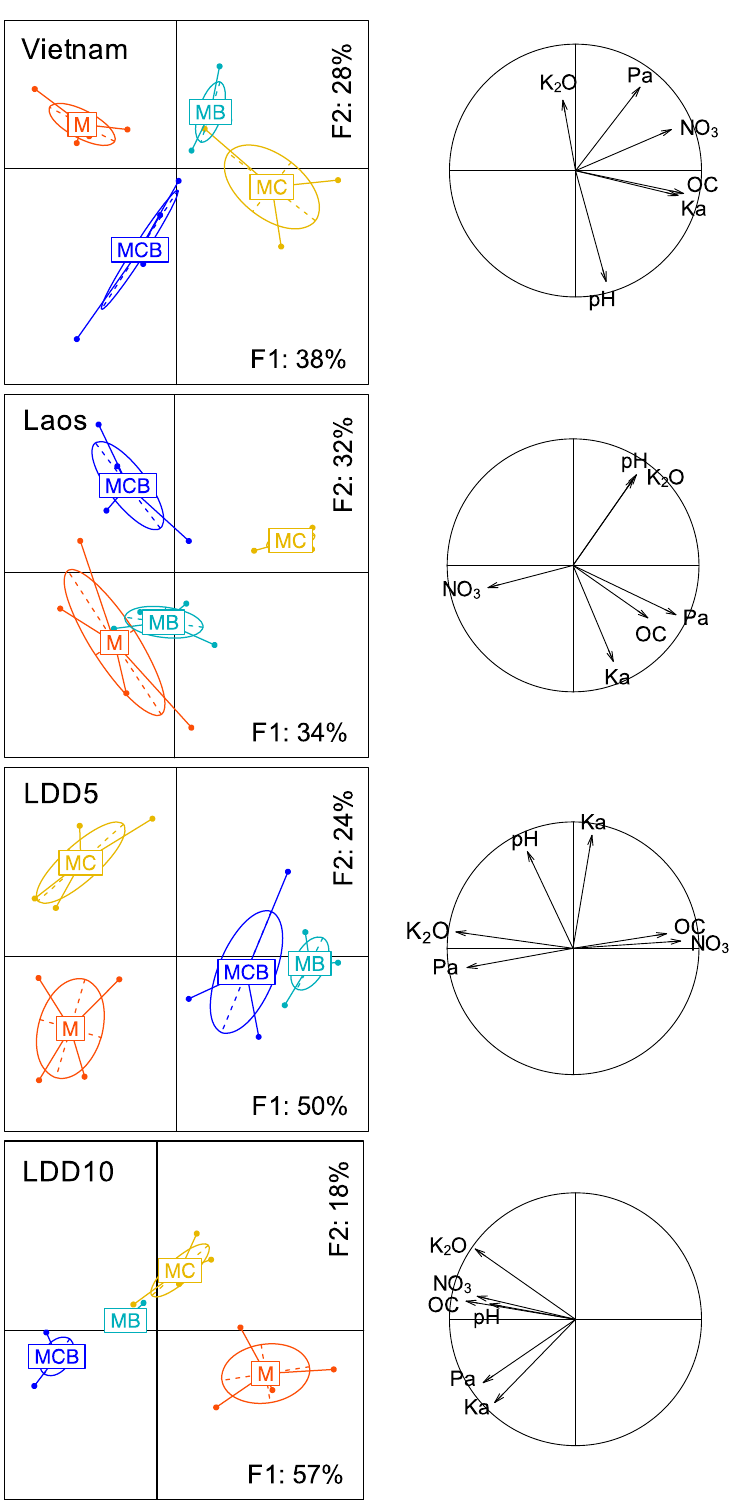
Figure 2. Biplot showing the principal component analysis (PCA) performed on soil chemical properties presenting statistically significant differences between treatments: (M) only NPK, (MB) NPK + biochar; (MC) NPK + compost and (MCB) NPK + compost and biochar. Variables are: pH H2O , OC, N, NO 3 − N, K and P total (P 2 O 5 , K 2 O), K and P available (Pa and Ka).